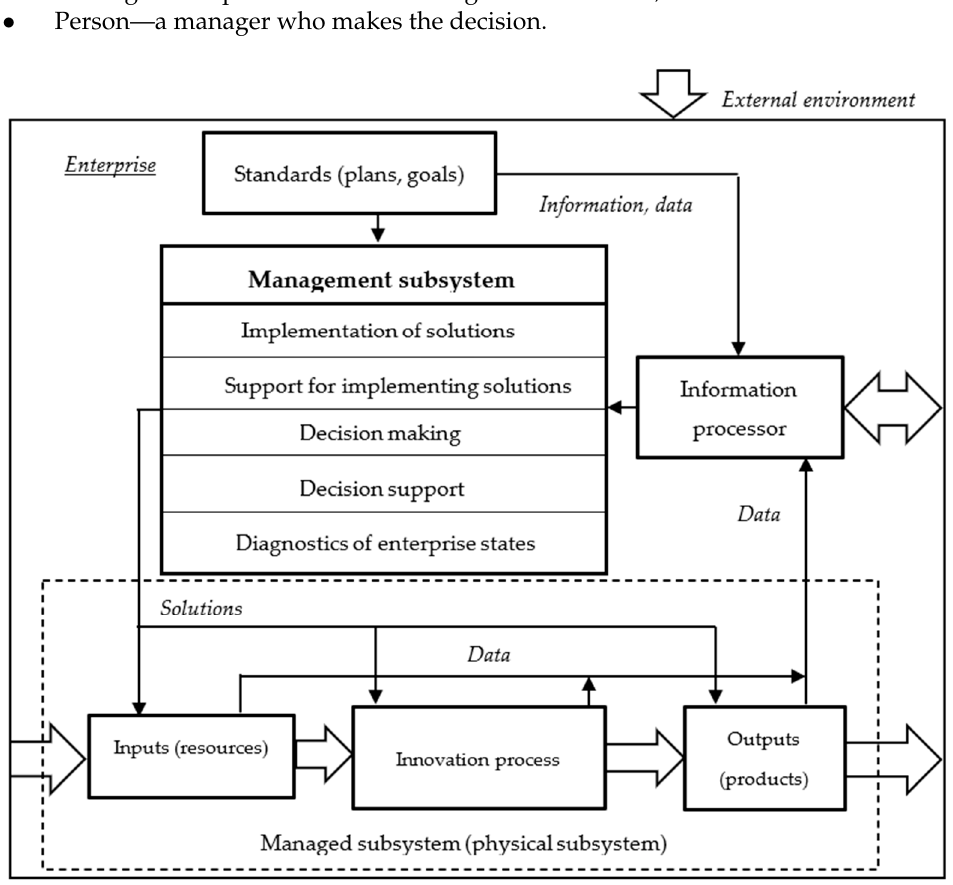
Figure 1. Enterprise system model.